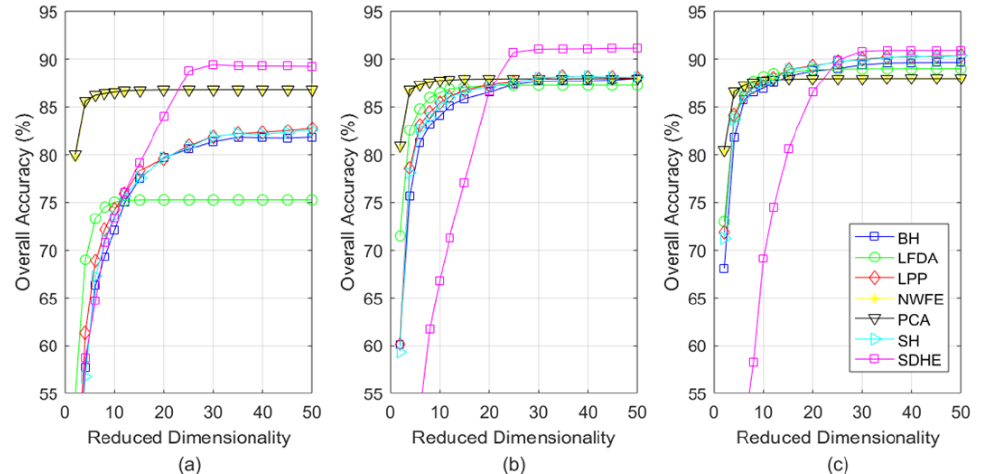
Figure 8. The OA (%) with the change of reduced dimensionality for Salinas. ( a ) Indicates the training set of 15 samples per class, ( b ) indicates the training set of 20 samples per class, ( c ) indicates the training set of 25 samples per class.